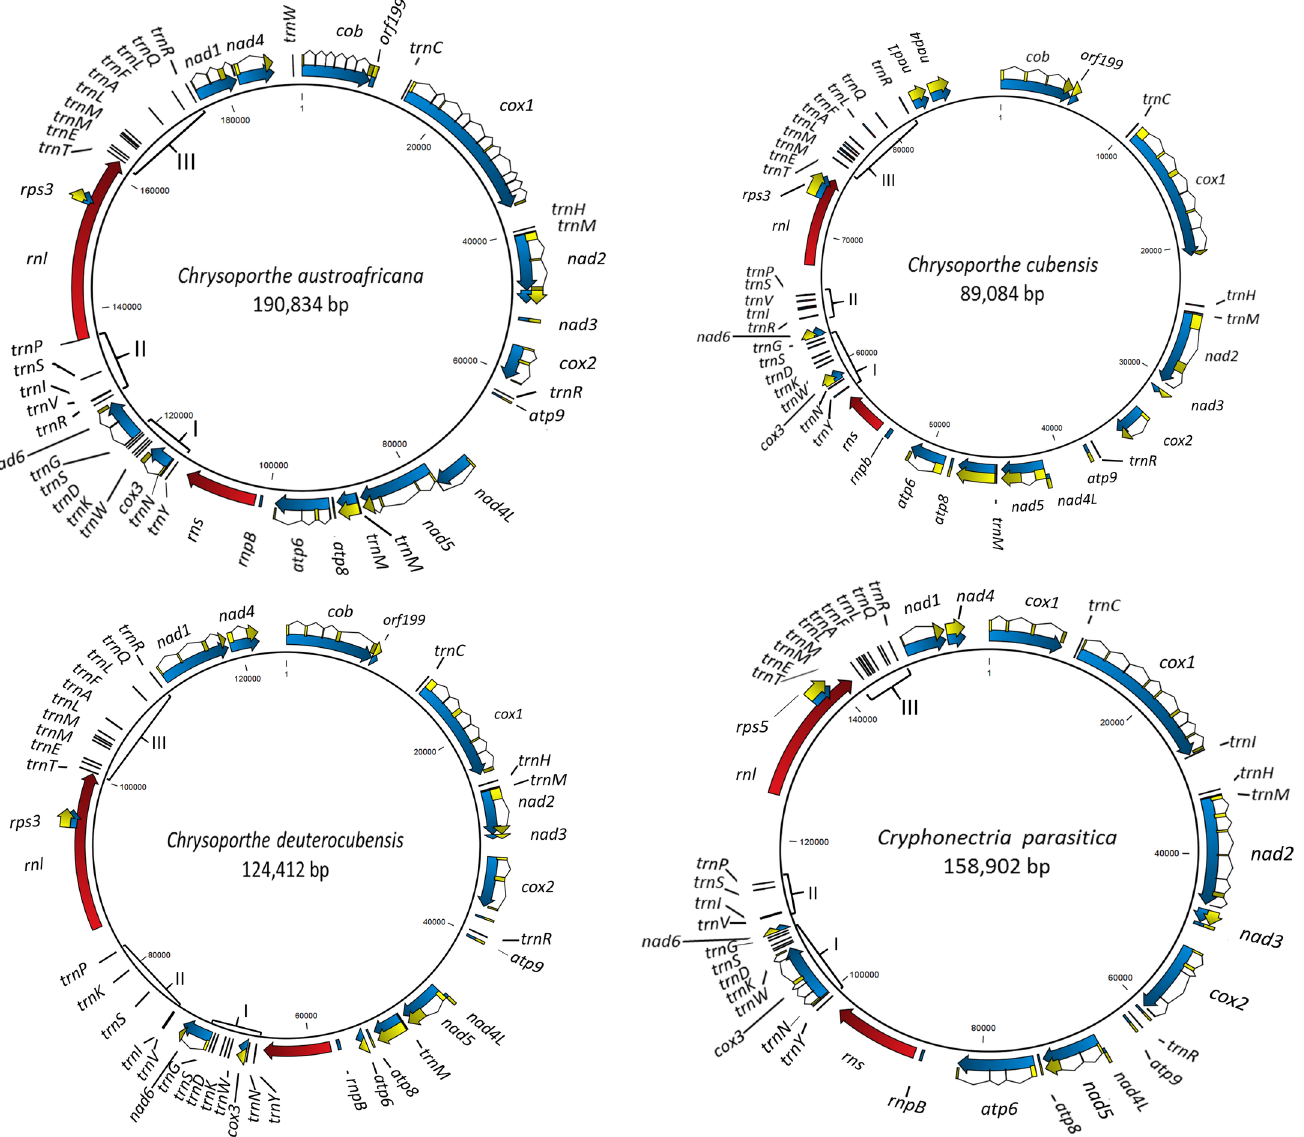
Fig 1. Physical maps of the mitochondrial (mt) genomes of Chrysoporthe austroafricana , C . cubensis , C . deuterocubensis and C . parasitica mitochondrial (mt) genomes. The 14 genes involved in oxidative phosphorylation and electron transport are shown. Blue arrowed lines indicate full length genes and direction of transcription. Yellow blocks connected by lines indicate the coding sequences (CS), red arrowed lines show the large and small subunit ribosomal RNAs, and black lines indicate transfer RNA (tRNA) genes. Curly brackets labelled I, II and III indicate the major tRNA clusters.